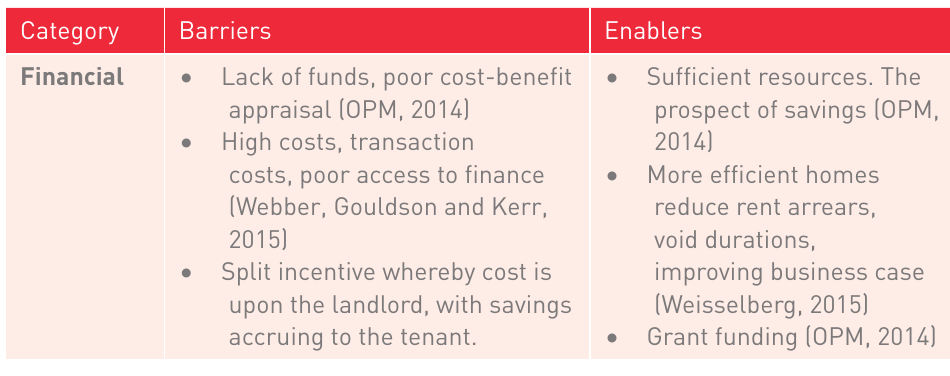
Barriers and Enablers to EERSH Category Barriers